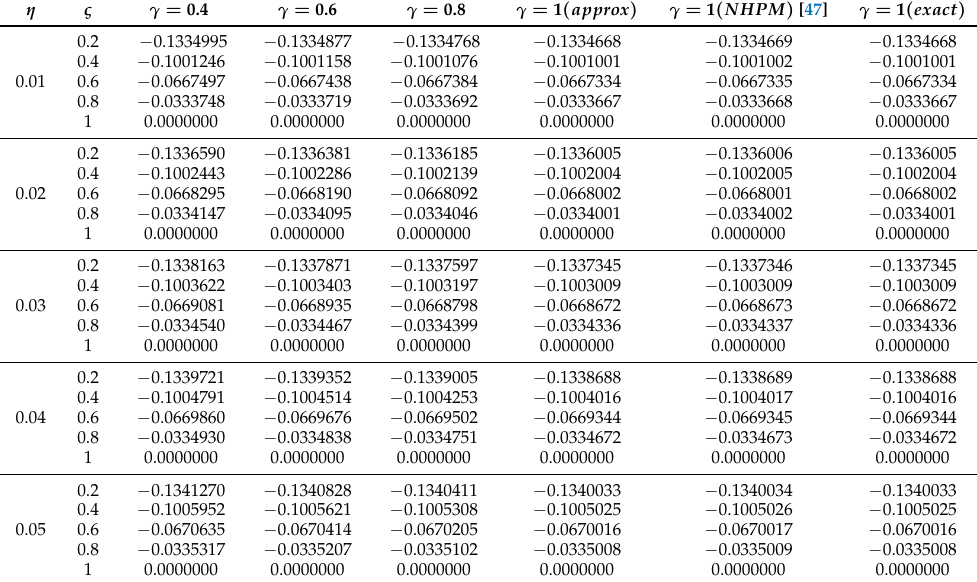
Table 2. Comparison of the accurate and suggested technique solution at different values of γ for problem 2.